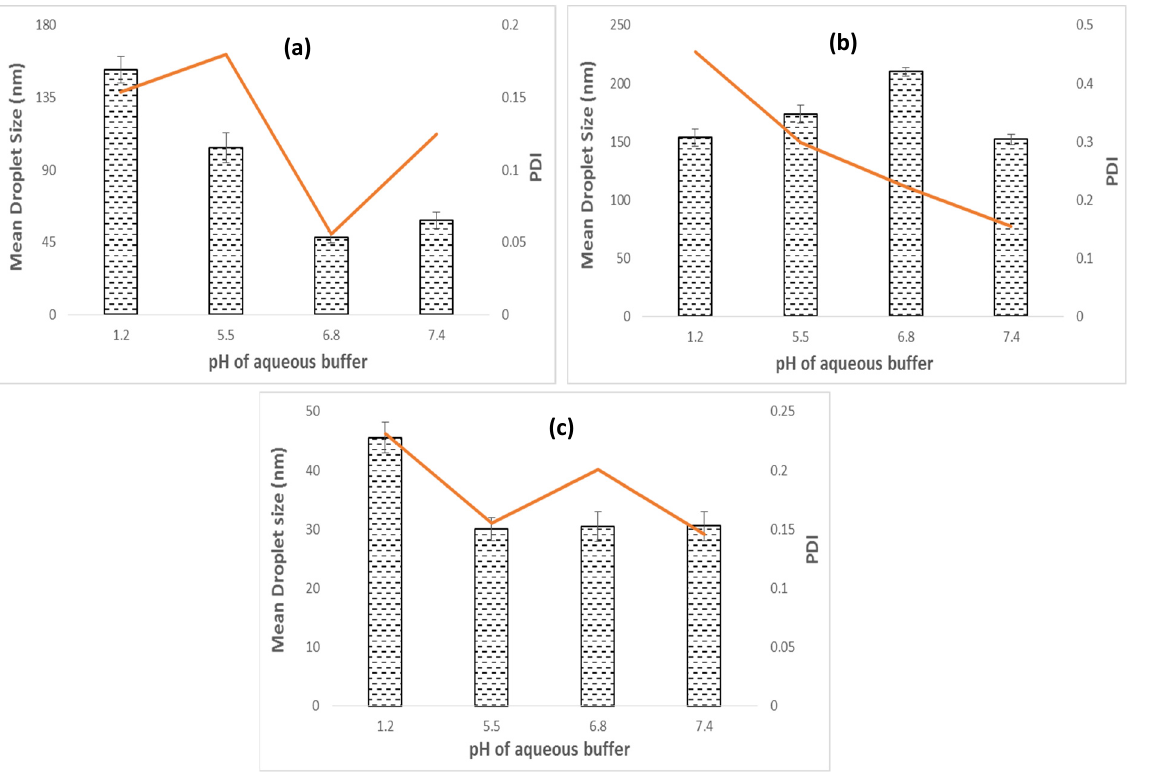
Figure 4. Impact of buffers of different pH on mean droplet size and PDI of NE system composed of ( a ) OA as oil phase; ( b ) C90 as oil phase; ( c ) EO as oil phase.